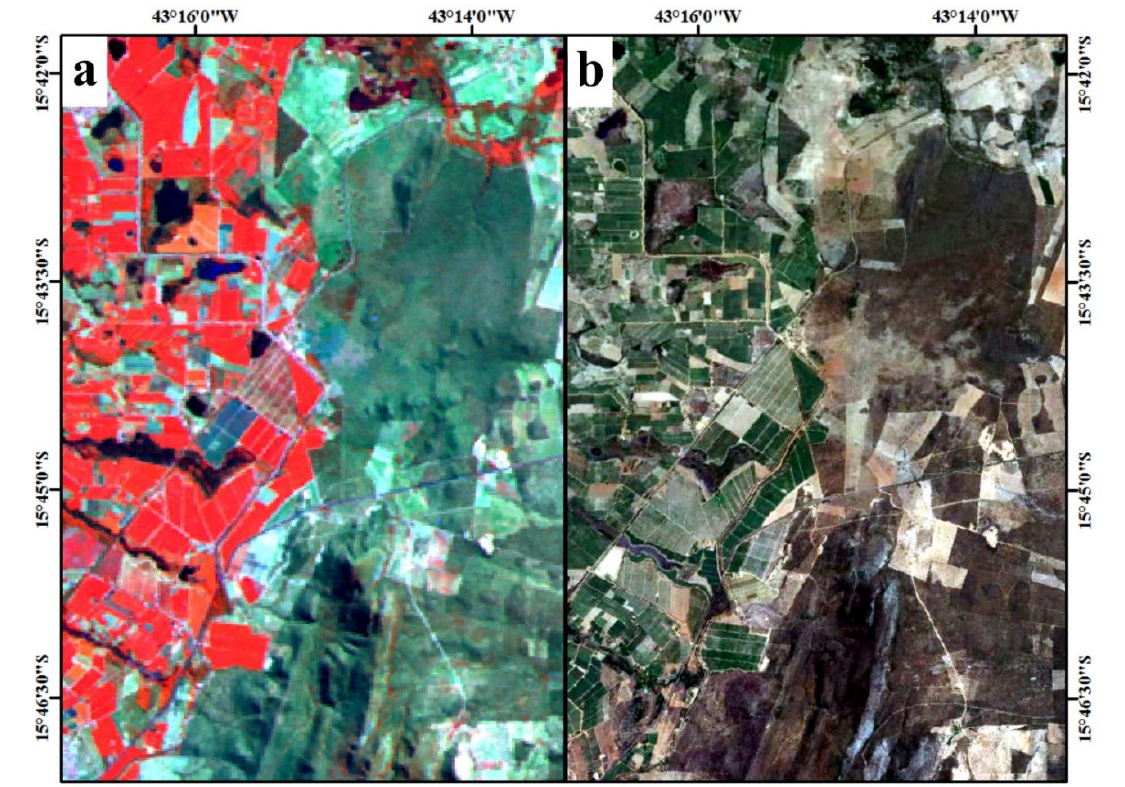
Figure 4. ( a ) Landsat-5 TM image from 12 September 2011, RGB color composite of TM bands 4 (red), 5 (green), and 3 (blue) and ( b ) high-resolution images from Google Earth from